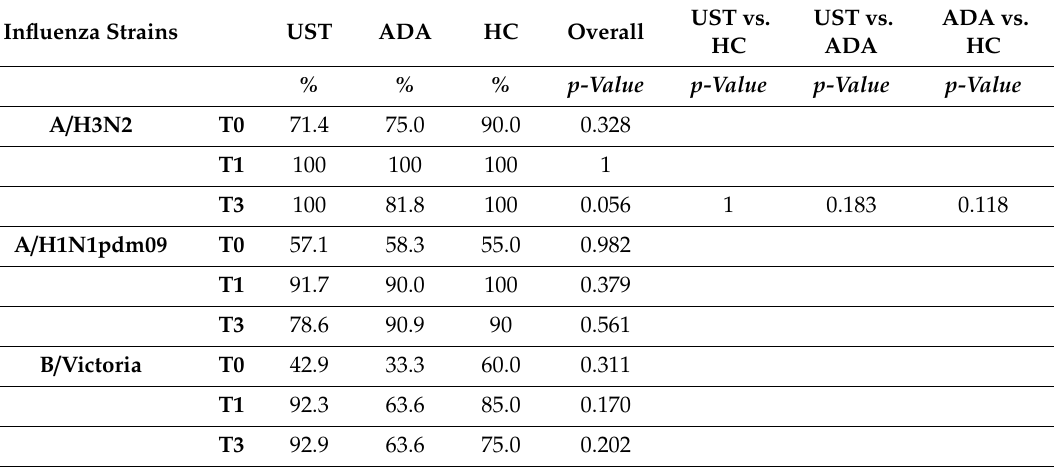
Table 2. Seroprotection rates per study group (% HI–titers ≥